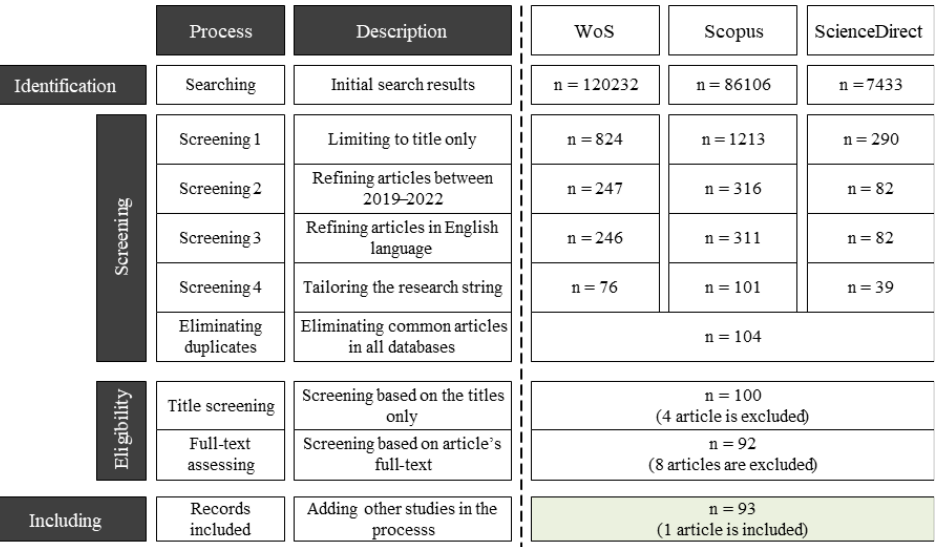
Figure 2. PRISMA flow diagram.